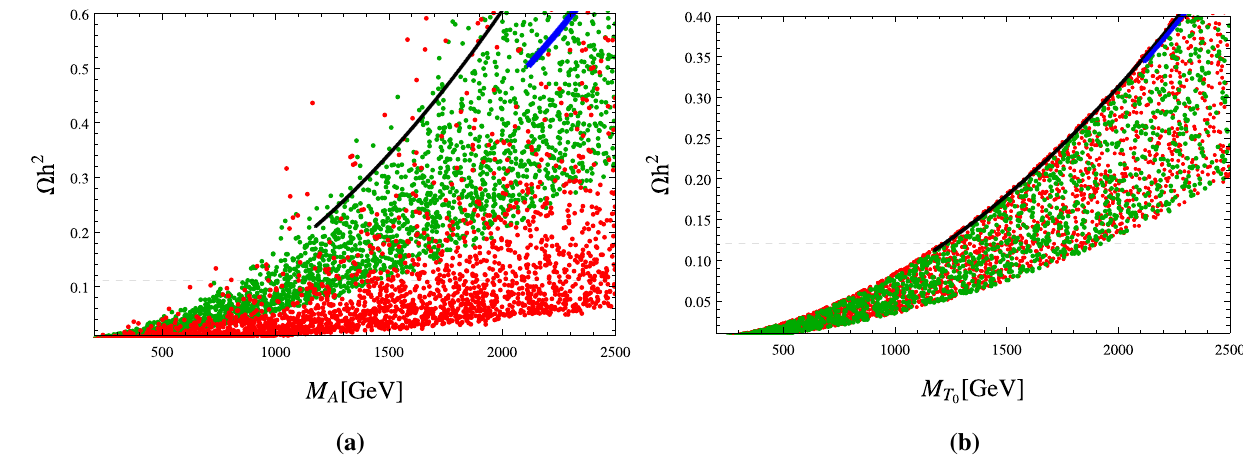
Fig. 15 Relic density vs dark matter mass in GeV. a Inert Higgs Dou- blet Model; b inert Higgs Triplet Model. Red color corresponds to the electroweak symmetry breaking allowed points, Green color cor- responds to the points which are allowed by both perturbativity and